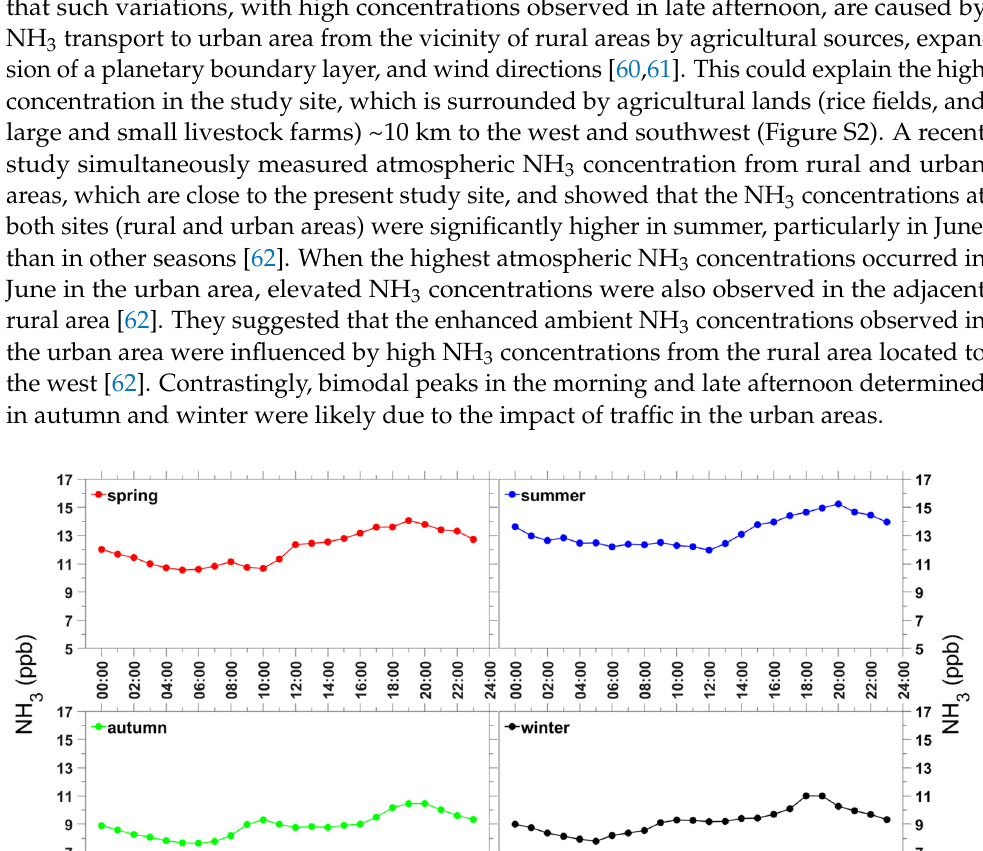
Seasonally, the NH 3 concentration in Jeonju was observed as follows: